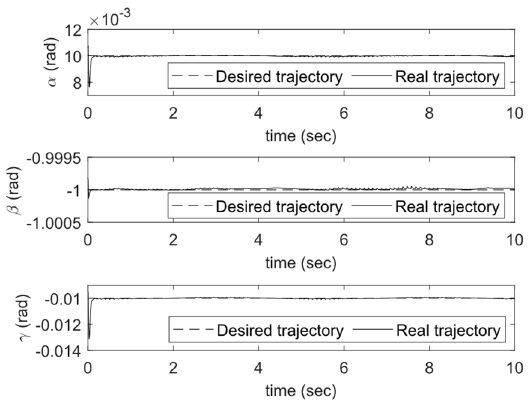
Figure 7. 3D position behavior of UR5 in the presence of the proposed controller.